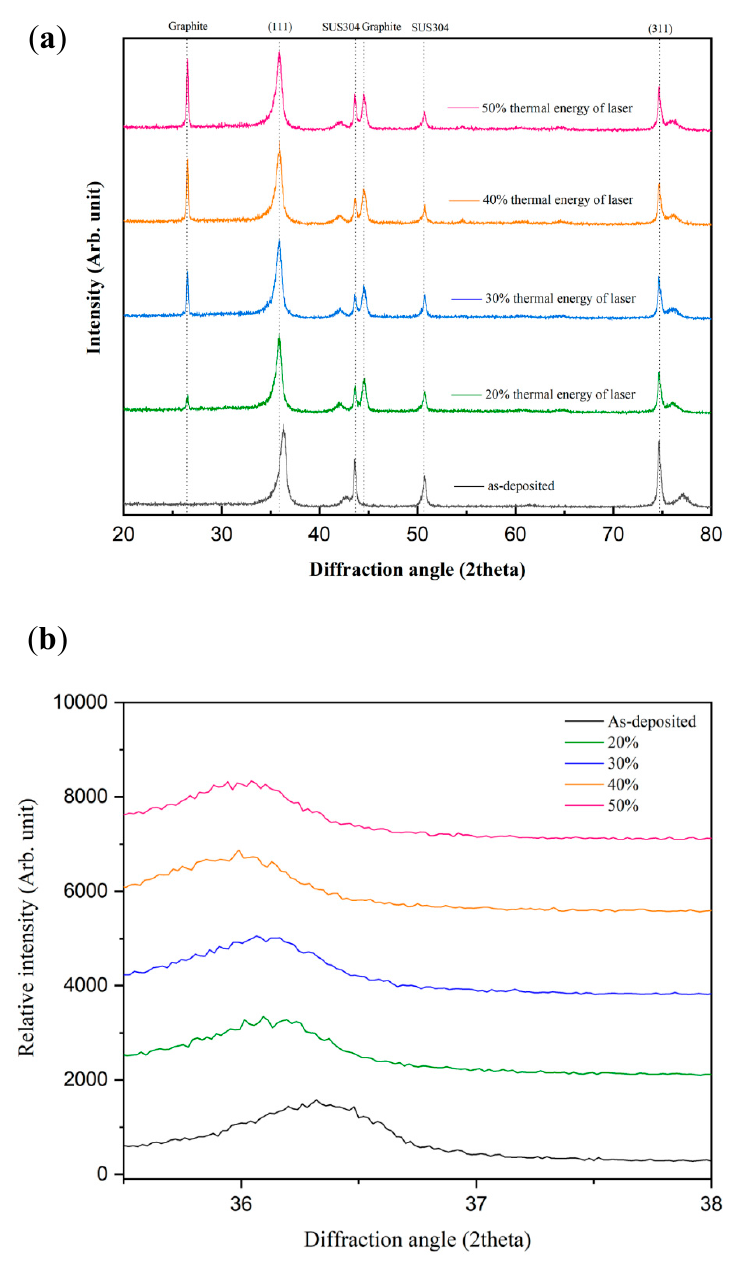
Figure 4. ( a ) HR-XRD patterns of as-deposited TiZrN and carbon-doped TiZrN peaks with increasing laser output, ( b ) HR-XRD patterns of TiZrN (111) peaks with increasing laser output.